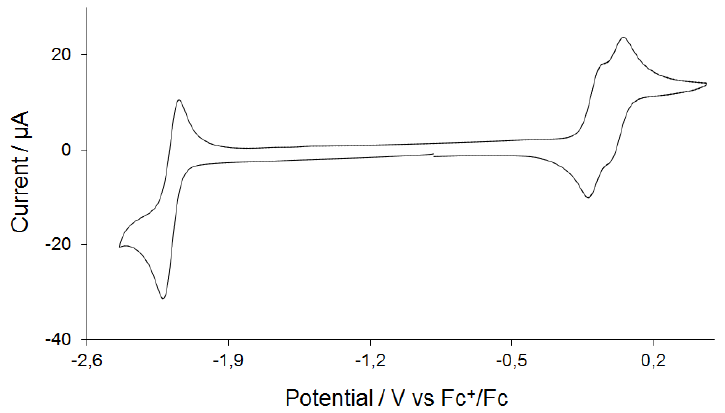
Figure 3. Cyclic Voltammogram (CV) of [Fe 2 (CO) 4 ( κ 2 -dppn)( µ -edt)] ( 3 ) in MeCN (1 mM solution, supporting electrolyte [NBu 4 ][PF 6 ], scan rate 0.1 V · s − 1 , glassy carbon electrode, potential vs. Fc + /Fc).